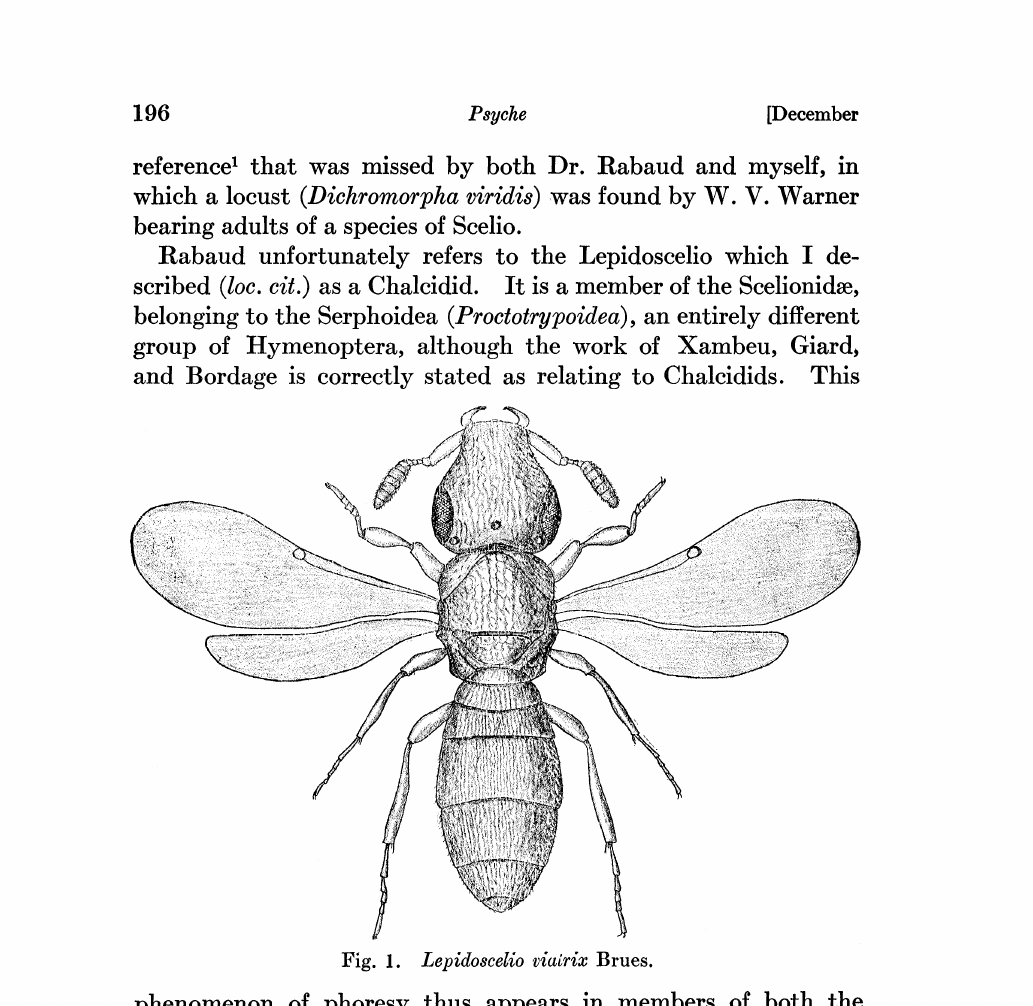
Fig. 1. LepidosceIio viairix